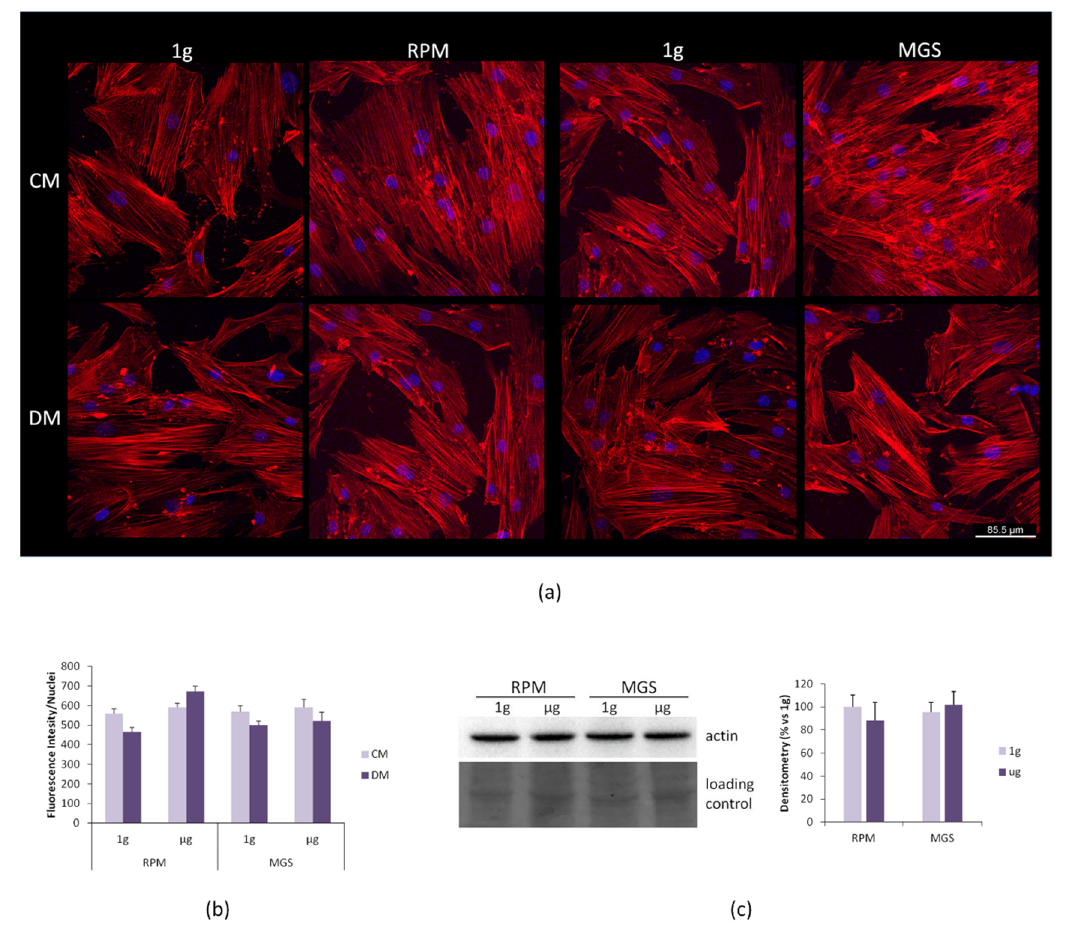
Figure 4. bMSC were cultured in the RPM or in the MGS as well as in 1 g-ground control for 4 days. ( a ) After fixation, the cells were stained with rhodamine labeled phalloidin and 4 (cid:48) ,6-diamidine-2 (cid:48) -phenylindole dihydrochloride (DAPI). ( b ) Phalloidin fluorescence was quantified by ImageJ. ( c ) Western blot using antibodies against β -actin was performed on cell extracts of bMSC cultured in 1g or simulated microgravity in standard culture medium (CM). The lower panel shows the loading control. Densitometry was performed using ImageJ.